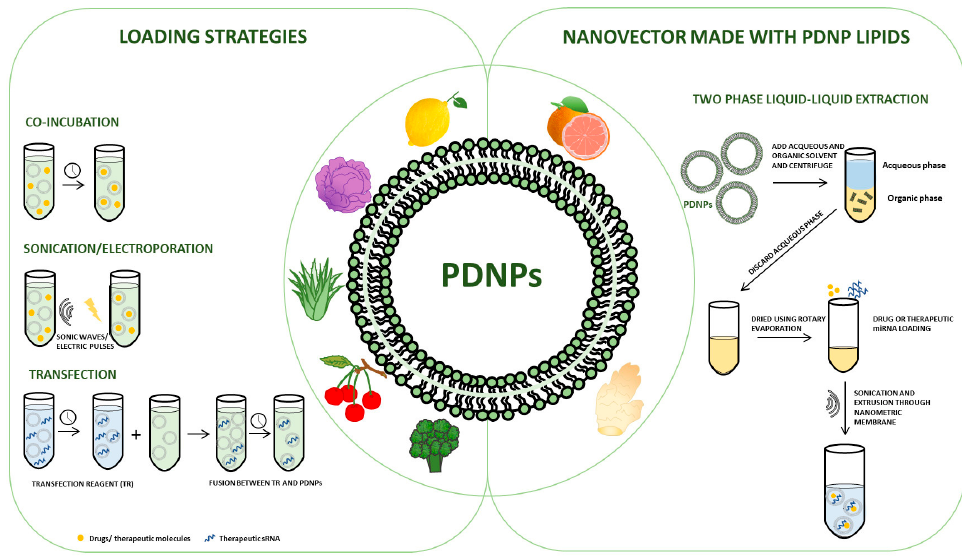
Figure 1. Schematic representation of the techniques used to date for: (left panel) the loading of exogenous substances into PDNPs; (right panel) the reassembly of lipids derived from PDNPs for the generation of natural nanovectors for use in the field of drug delivery.